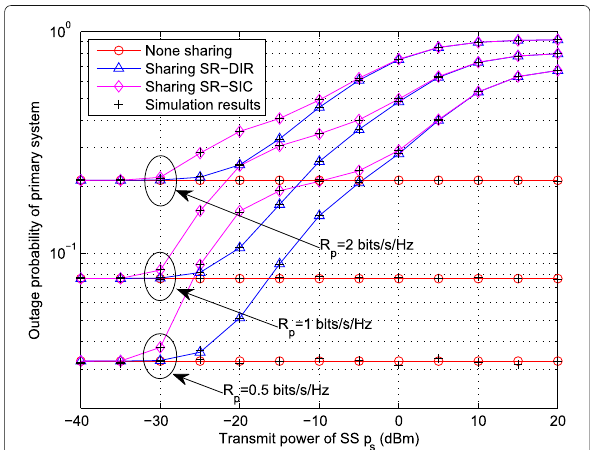
Fig. 4 Outageprobabilityof primary system vs the transmit power of SS